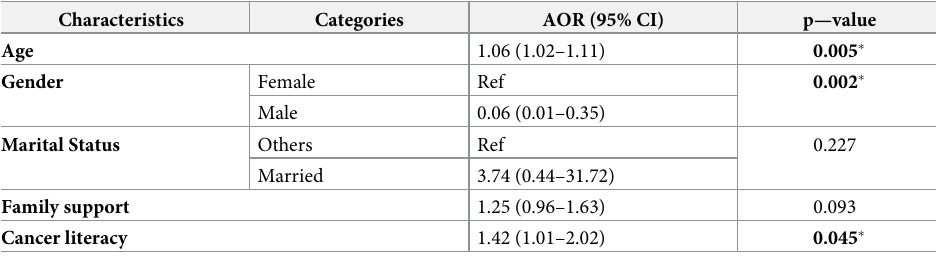
Table 6. Multivariate logistic regression analysis of socio-demographic characteristics; need, pre-disposing and enabling factors; and cancer literacy scores with cancer screening behaviour among the study participants (n =